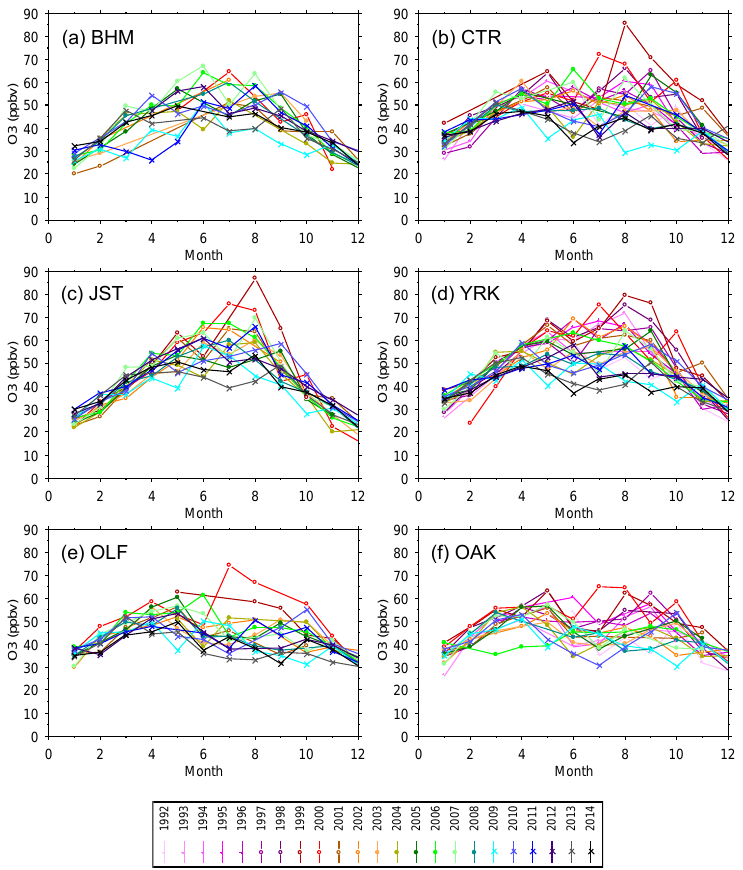
Figure 4. Monthly means of daily peak 8h average O 3 mixing ratios. All monthly means are determined from 24 or more days with 18 or more sampling hours per day. Standard errors of the means average 2 (range